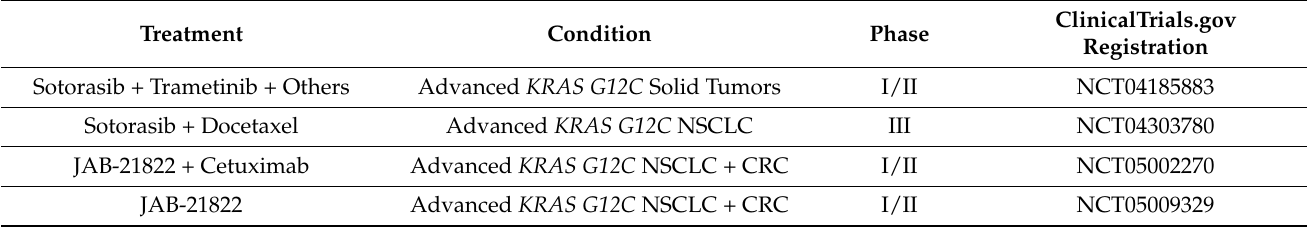
Table 1. Current clinical trials using allele-specific RAS inhibitors. Treatment Condition Phase